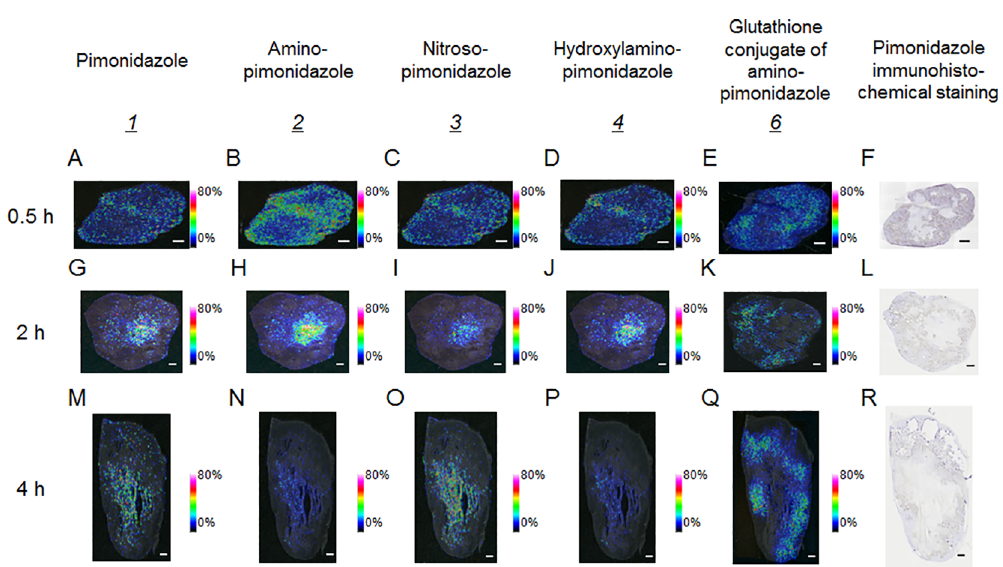
Fig 2. Representative mass spectrometric images of pimonidazole and its low-molecular mass metabolites and pimonidazole immunohistochemical staining in mouse tumors 0.5, 2 and 4 h after administration of pimonidazole. The scale bar represents 1 mm. (A) – (F): Mass spectrometric images of mouse tumor 0.5 h after administration. (G) – (L): Mass spectrometric images of mouse tumor 2 h after administration. (M) – (R): Mass spectrometric images of mouse tumor 4 h after administration. (A), (G), (M): Mass spectrometric images of m/z 255.145, representing pimonidazole ( 1 ). (B), (H), (N): Mass spectrometric images of m/z 225.171, representing amino-pimonidazole ( 4 ). (C), (I), (O): Mass spectrometric images of m/z 239.150, representing nitroso- pimonidazole ( 2 ). (D), (J), (P): Mass spectrometric images of m/z 241.166, representing hydroxylamino- pimonidazole ( 3 ). (E), (K), (Q): Mass spectrometric images of m/z 530.239, representing the glutathione conjugate of amino-pimonidazole ( 6 ). (H), (L), (R): pimonidazole immunohistochemical staining.